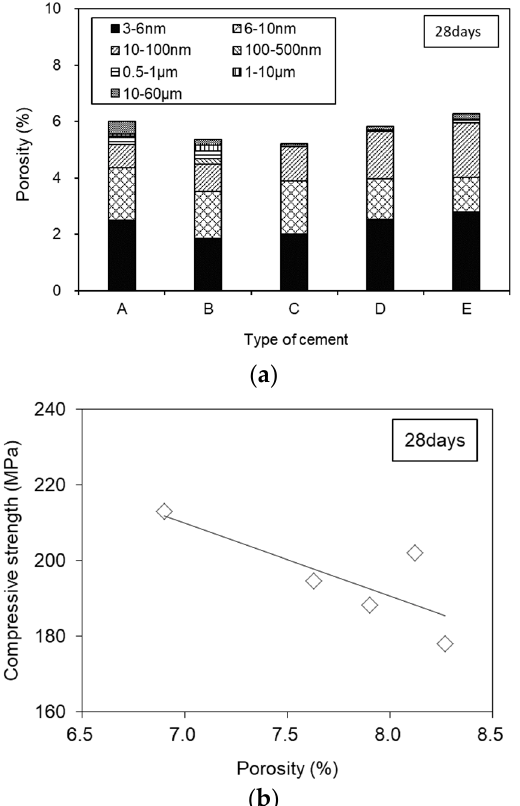
Figure 8. Porosity properties of mortar (W/B = 14%) made with various cement. ( a ) Porosity of mortar. ( b ) Porosity—compressive strength.